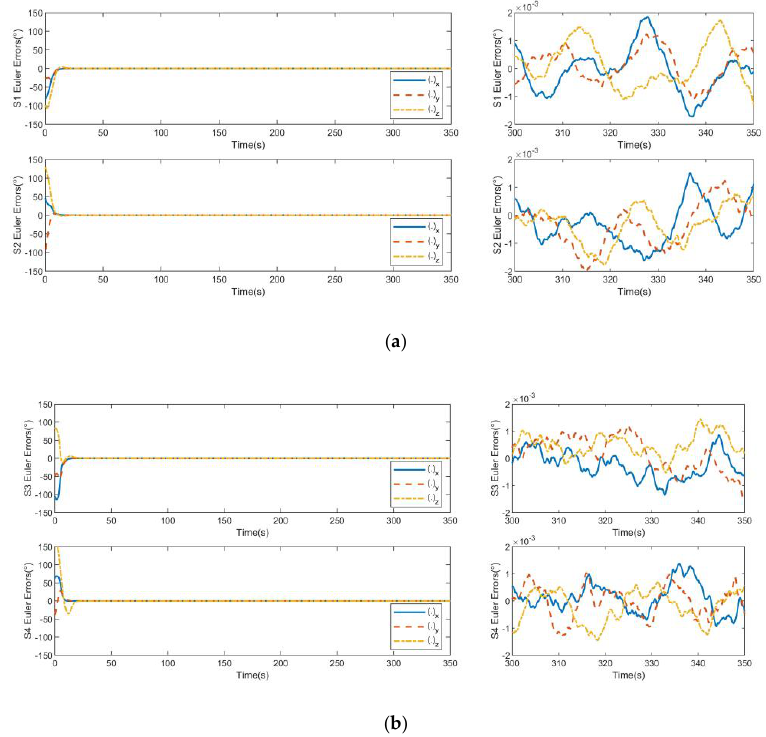
Figure 11. Euler errors for consistent collaborative control: ( a ) S1 Euler errors and S2 Euler errors; ( b ) S3 Euler errors and S4 Euler errors.